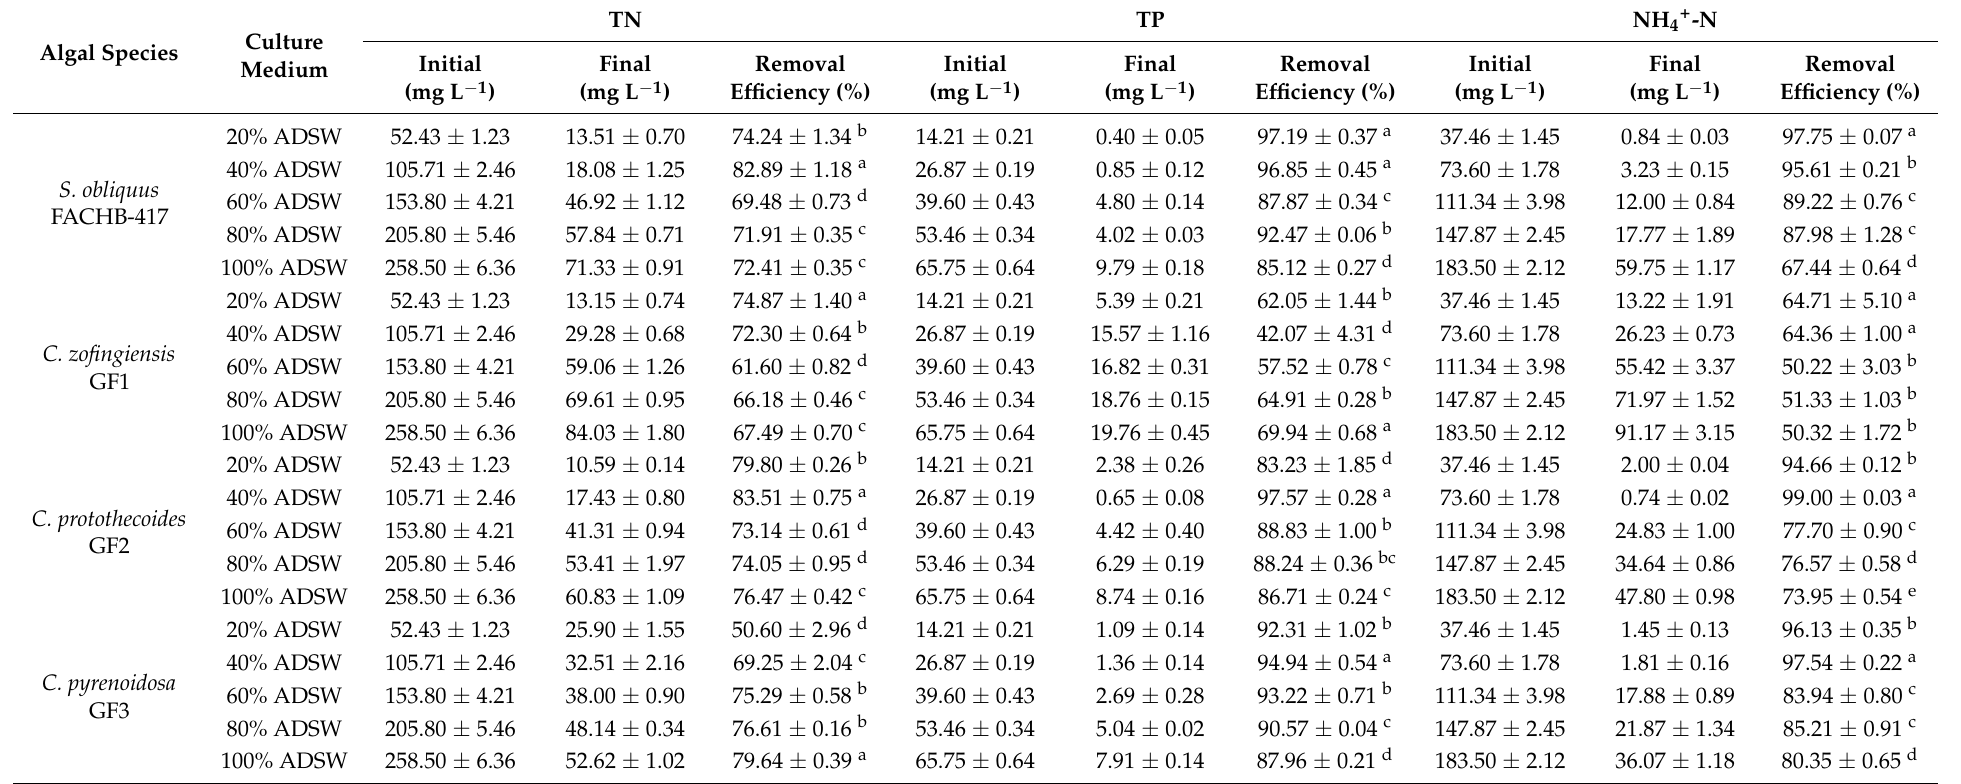
Table 3. Removal of TN, TP, and NH 4+ -N by six microalgal strains in five dilutions of ADSW and BG11 medium within 14